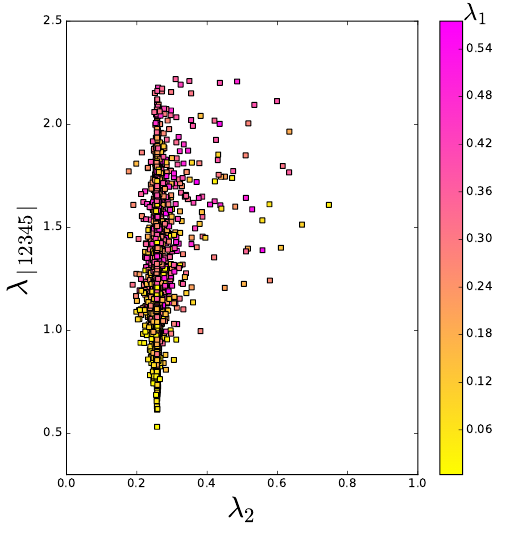
and λ 2 satisfying the constraints of pre- | 12345 |